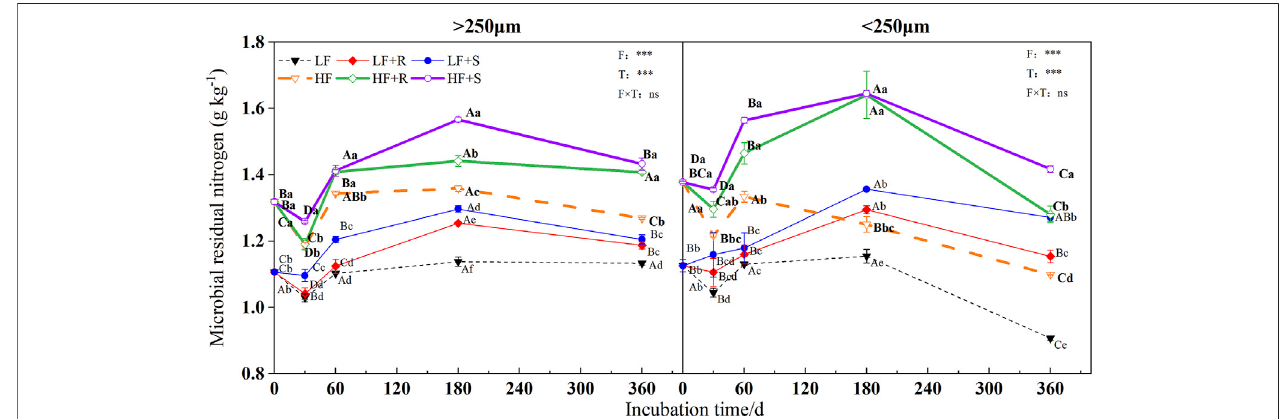
FIGURE 3 | Microbial residual nitrogen in soil aggregates with different fertility levels after the addition of different parts of maize residues. Note: LF means low fertility,LF+Rmeanslowfertility+roots,andLF+Smeanslowfertility+Shoots;HFmeanshighfertility,HF+Rmeanshighfertility+roots,andHF+Smeanshighfertility + Shoots. Uppercase letters represent differences between different periods in the same treatment, and lowercase letters represent differences between different treatments at the same period. For the ANOVA, F means fertility level, T means the type of maize residues, and F × T means fertility level × type of maize residues. *,**, and *** mean p < 0.05, 0.01, and 0.001, respectively. ns means no signi fi cance.